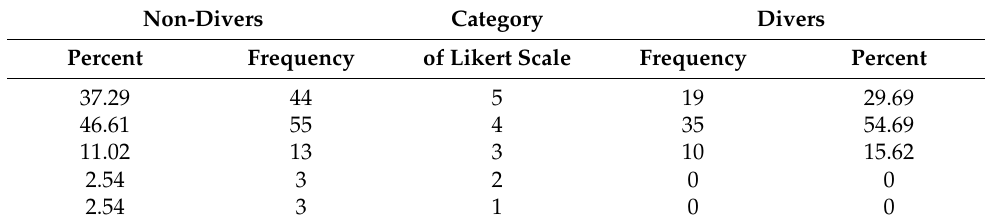
Table 6. Scuba diving impact on overall physical